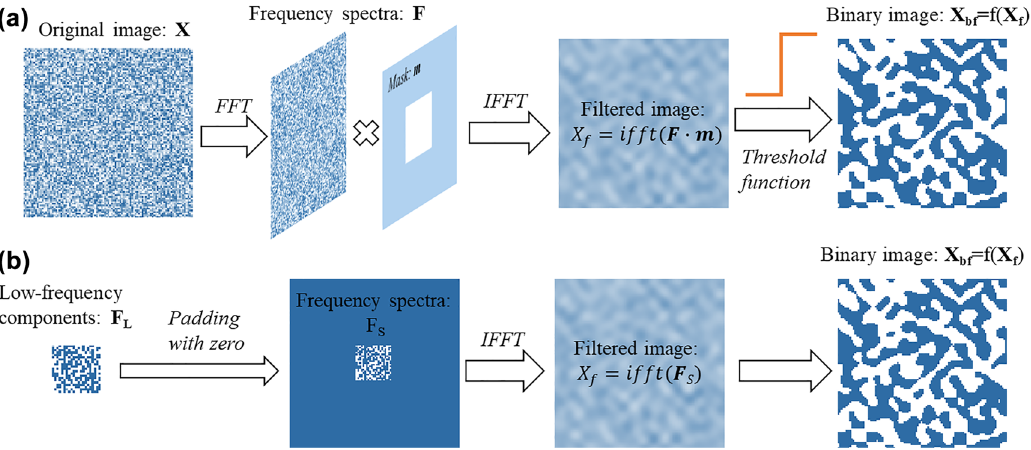
Figure 1: Minimal feature size control methods. (a) Control the minimal feature size by filtering out the high frequency components in the Fourier domain. (b) Utilizing the low-frequency components to reconstruct the real structure.